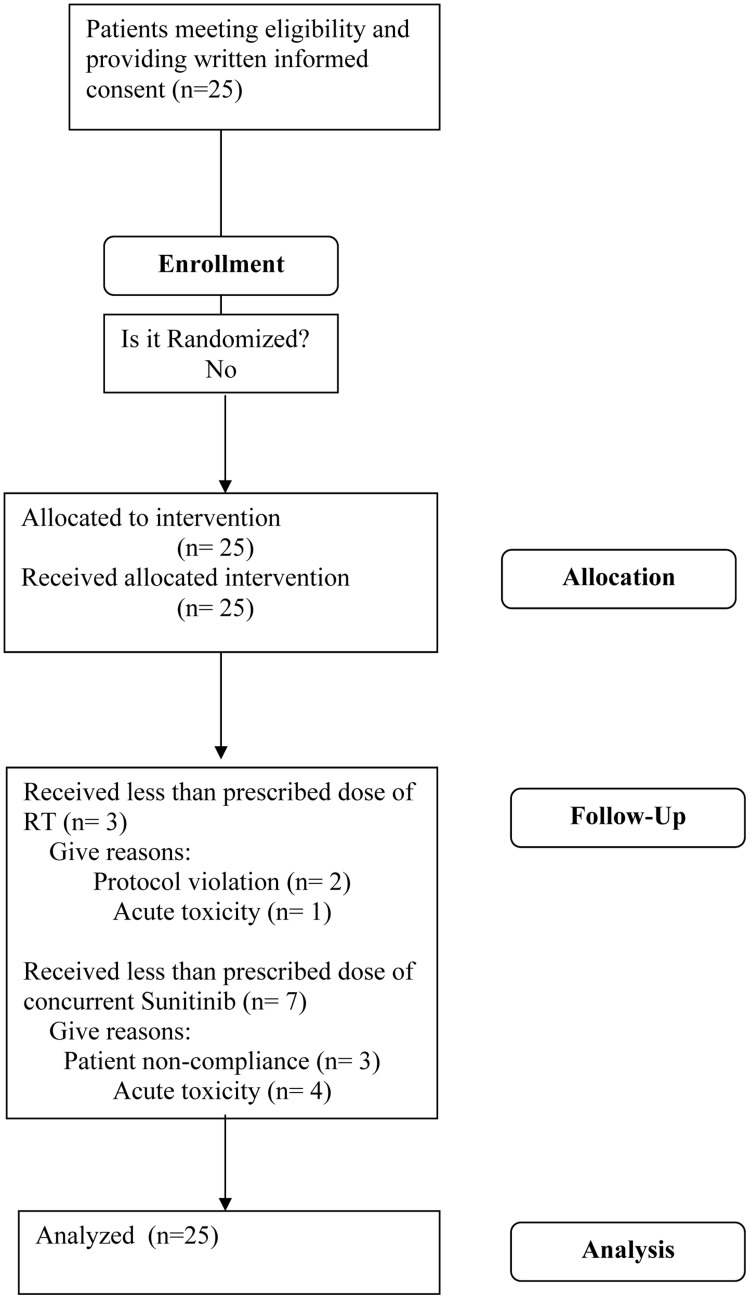
CONSORT flowchart.